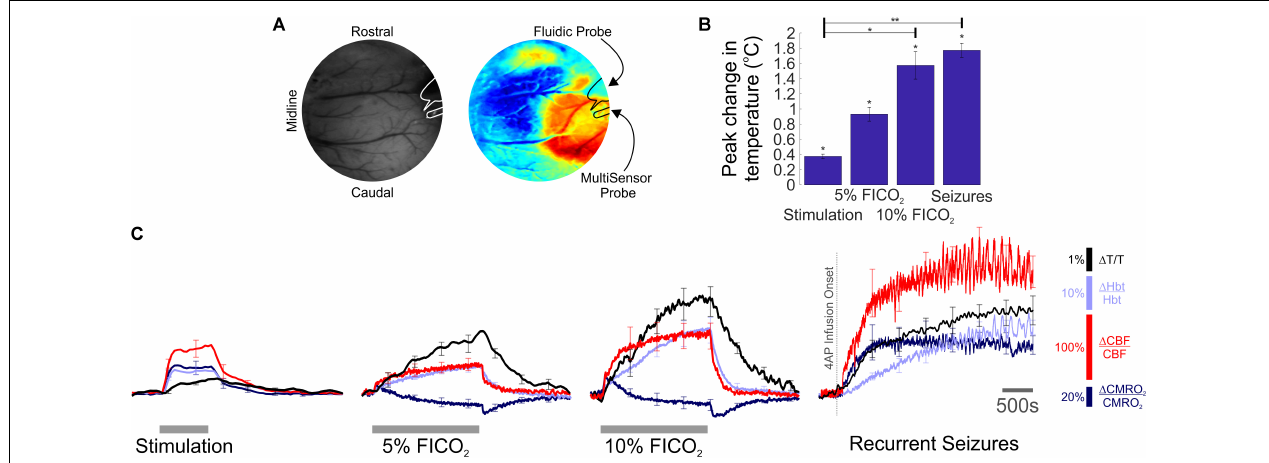
FIGURE 1 | Temperature, hemodynamic, and oxidative metabolism changes during sensory stimulation, graded hypercapnia and recurrent acute neocortical seizures. (A) Digital image of cortical surface showing implantation sites of recording probes in a representative animal (Left), colocalized to barrel cortex activated by whisker stimulation, and visualized using SPM (Right, blue, and red colors indicate negative and positive activation areas, respectively). (B) Averaged peak change in temperature during whisker stimulation ( N = 5), 5 and 10% fraction of inspired CO 2 (FICO 2 , N = 5 in each case) and recurrent seizures ( N = 6). Individual comparisons made using 1-tailed Wilcoxon signed-ranks tests. Statistical comparisons made using Kruskal–Wallis tests with Tukey-Kramer correction. ∗ P < 0.05 and ∗∗ P < 0.01. (C) Percentage change from baseline in cortical temperature (black), Hbt (light blue), CBF (red), and CMRO 2 (dark blue) during sensory stimulation (Left), graded hypercapnia (Middle) and recurrent acute neocortical seizures (Right, first 2,500 s of seizure activity), averaged across animals. Error bars are SEM.